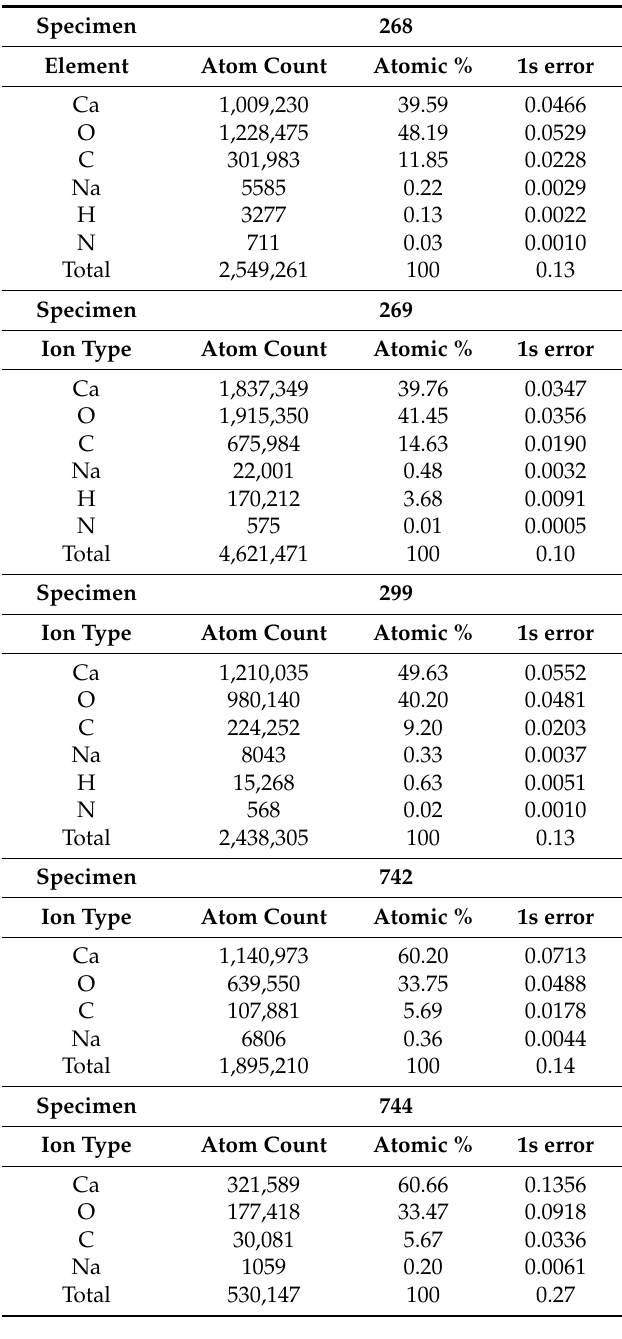
Table 2. Decomposed element tip composition (%